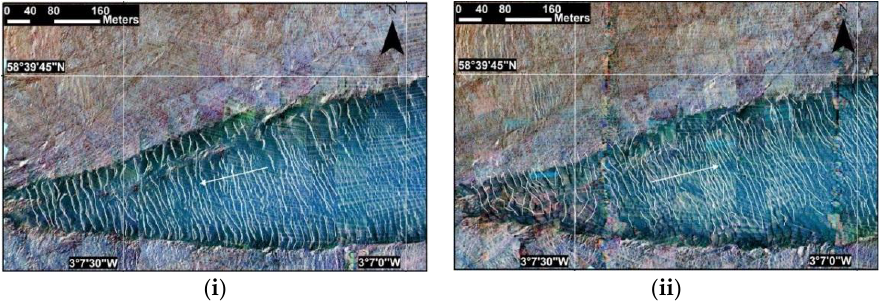
Figure 6. Side-scan mosaic showing shell bed dune orientation during spring ebb tide ( i ) and spring flood tide ( ii ).